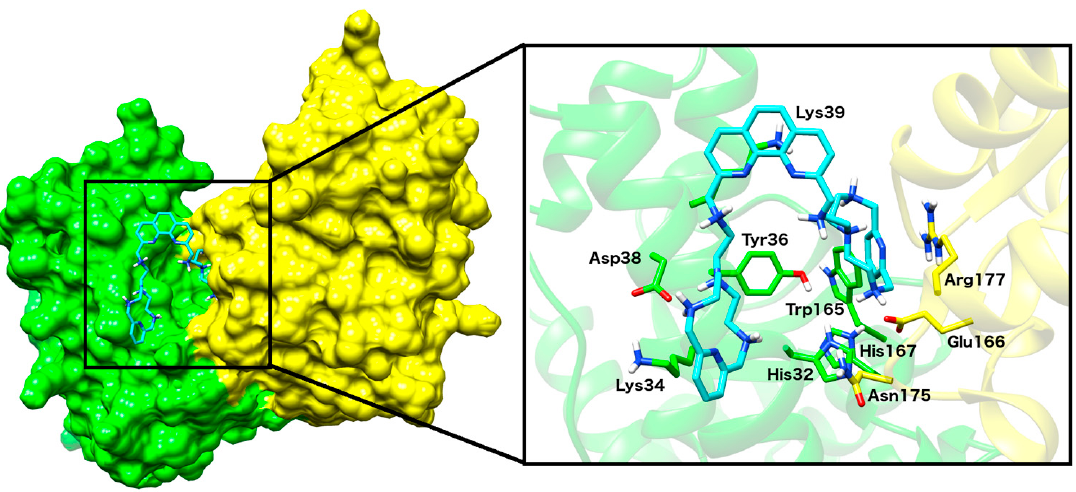
Figure 4. Proposed binding mode of compound 15 to the mitochondrial Fe-SOD enzyme (PDB ID 4DVH) (PubMed: 24616096). In the ( left ), the protein surface is shown, with one protomer in green and the other in yellow, and the compound as cyan sticks bound in the dimer interface. In the ( right ), we can see a close-up of the binding site. The following color scheme was used in the whole panel: oxygen (red), nitrogen (blue), hydrogen (white), and carbon (protein chain A in yellow and chain B in green-, compound 15 in cyan, orange or pink). The figures were created by the software Chimera.